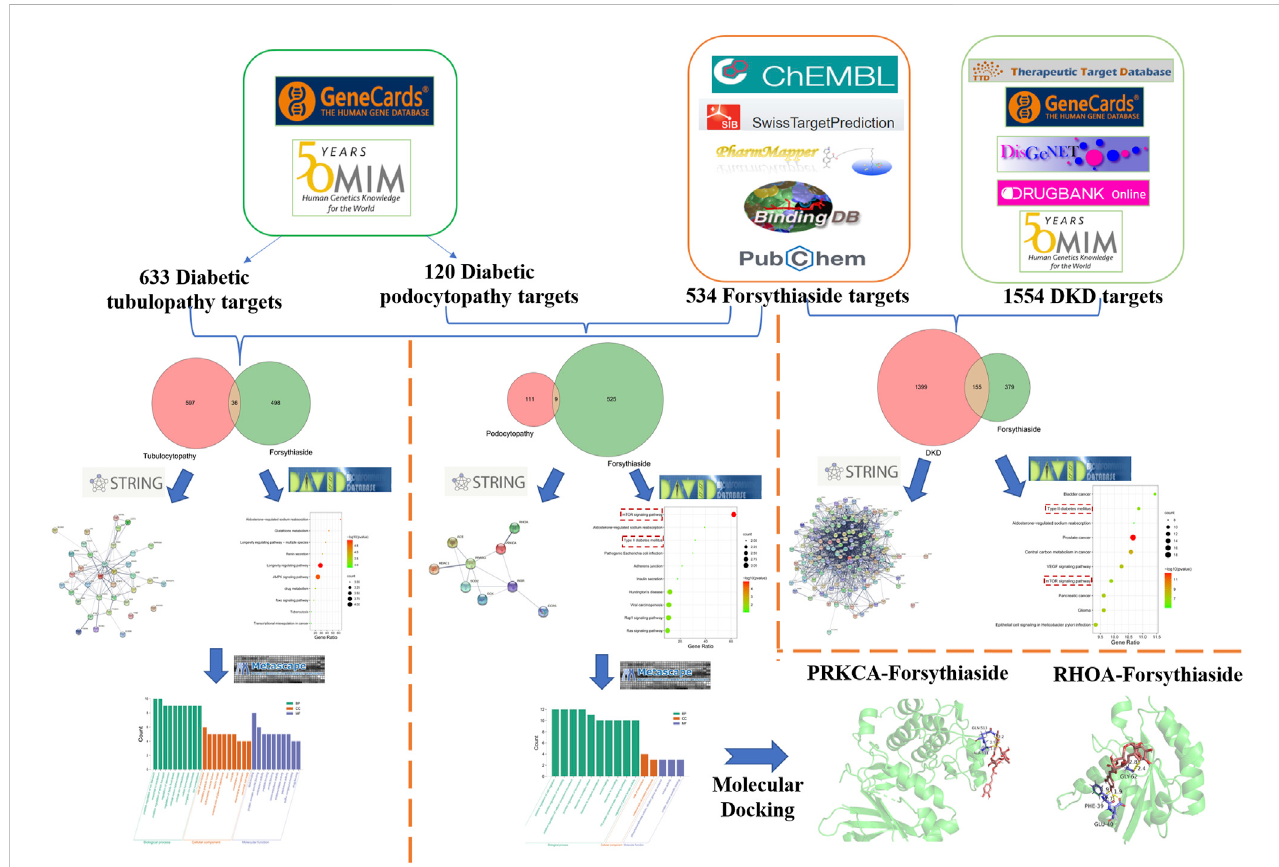
FIGURE 1 Flowchart of exploring the mechanisms of Forsythiaside in DKD from the speci fi c cellular level.